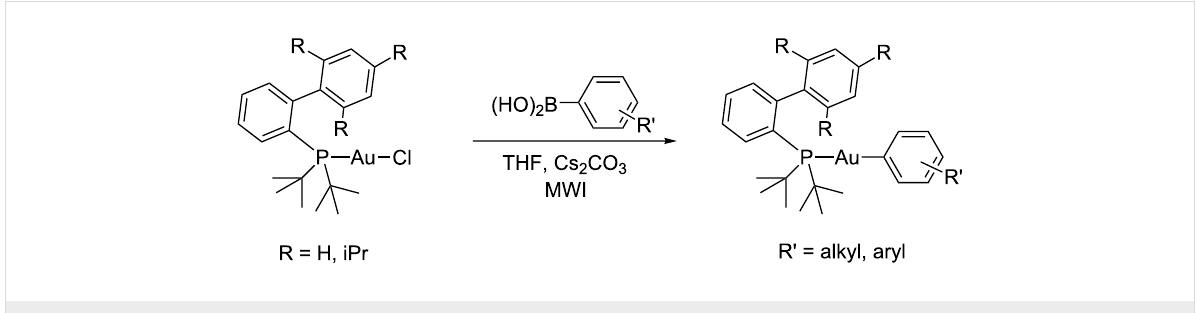
Scheme 1: Microwave assisted synthesis of arylgold